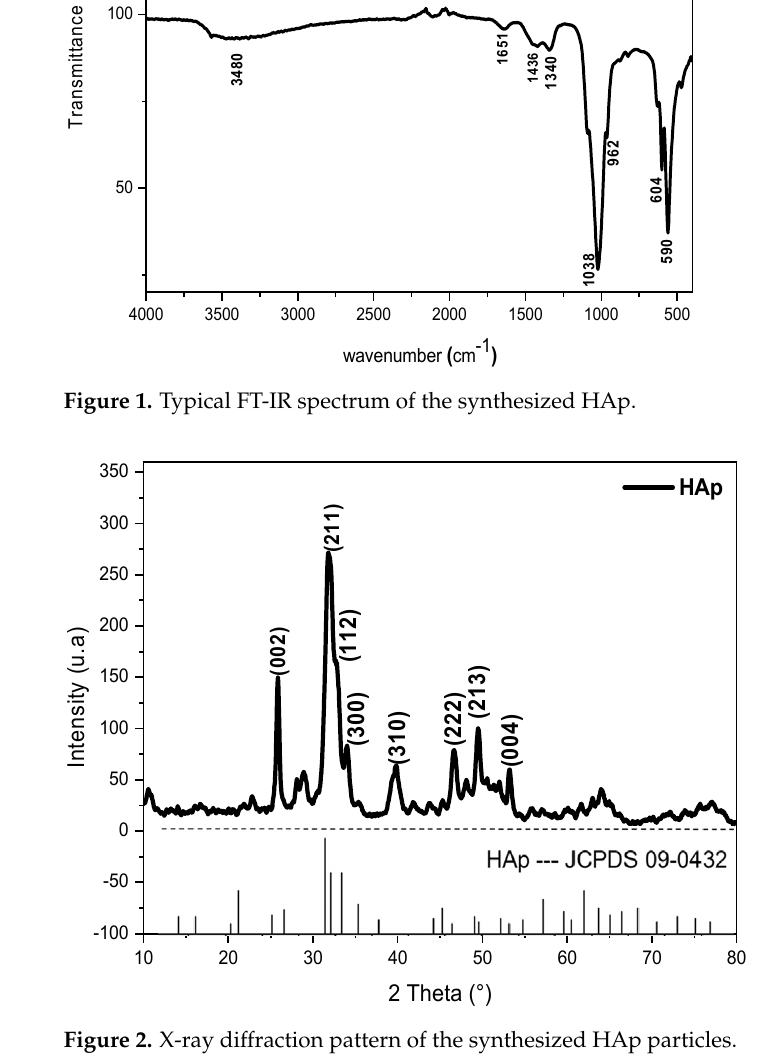
Figure 1. Typical FT-IR spectrum of the synthesized HAp.